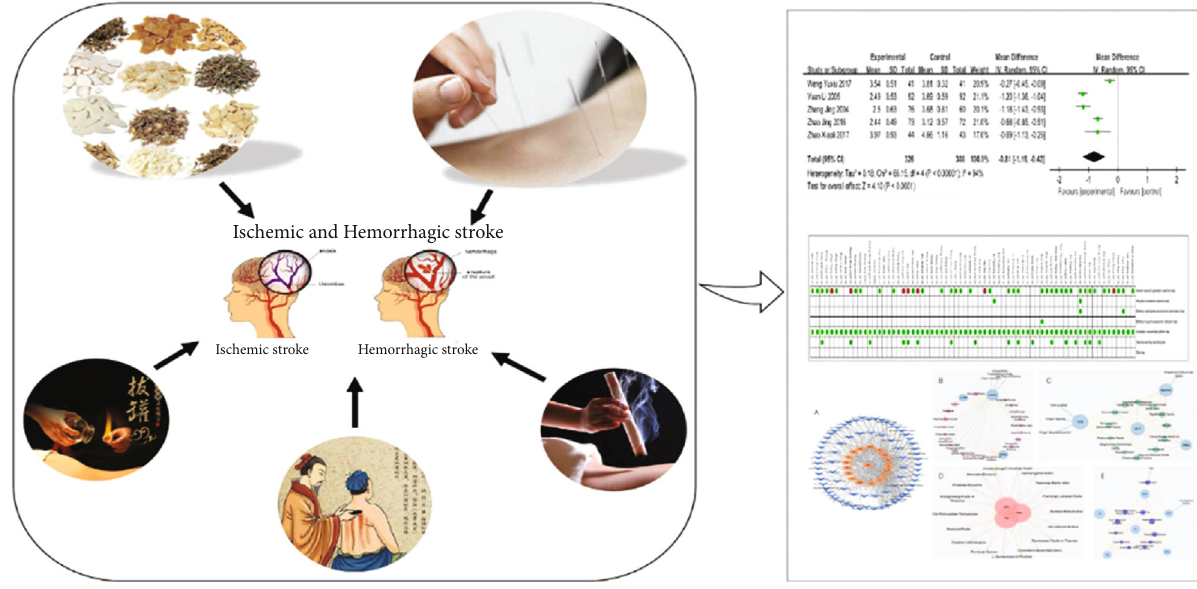
Figure 1: Work fl ow of the present